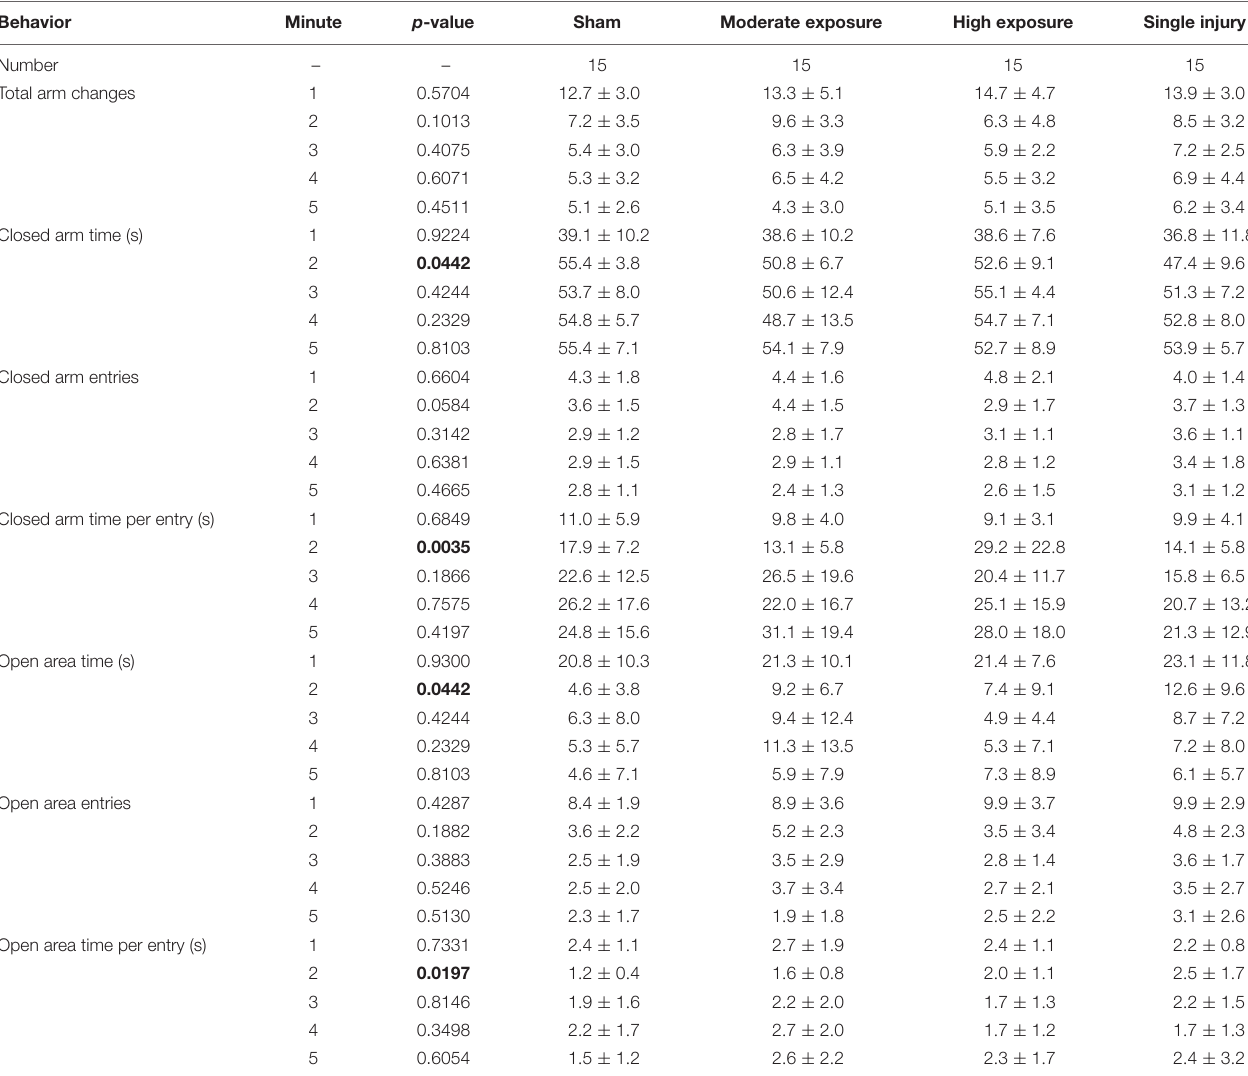
TABLE 2 | Open and closed arm metrics for each minute of the elevated plus maze assessment (mean ± standard